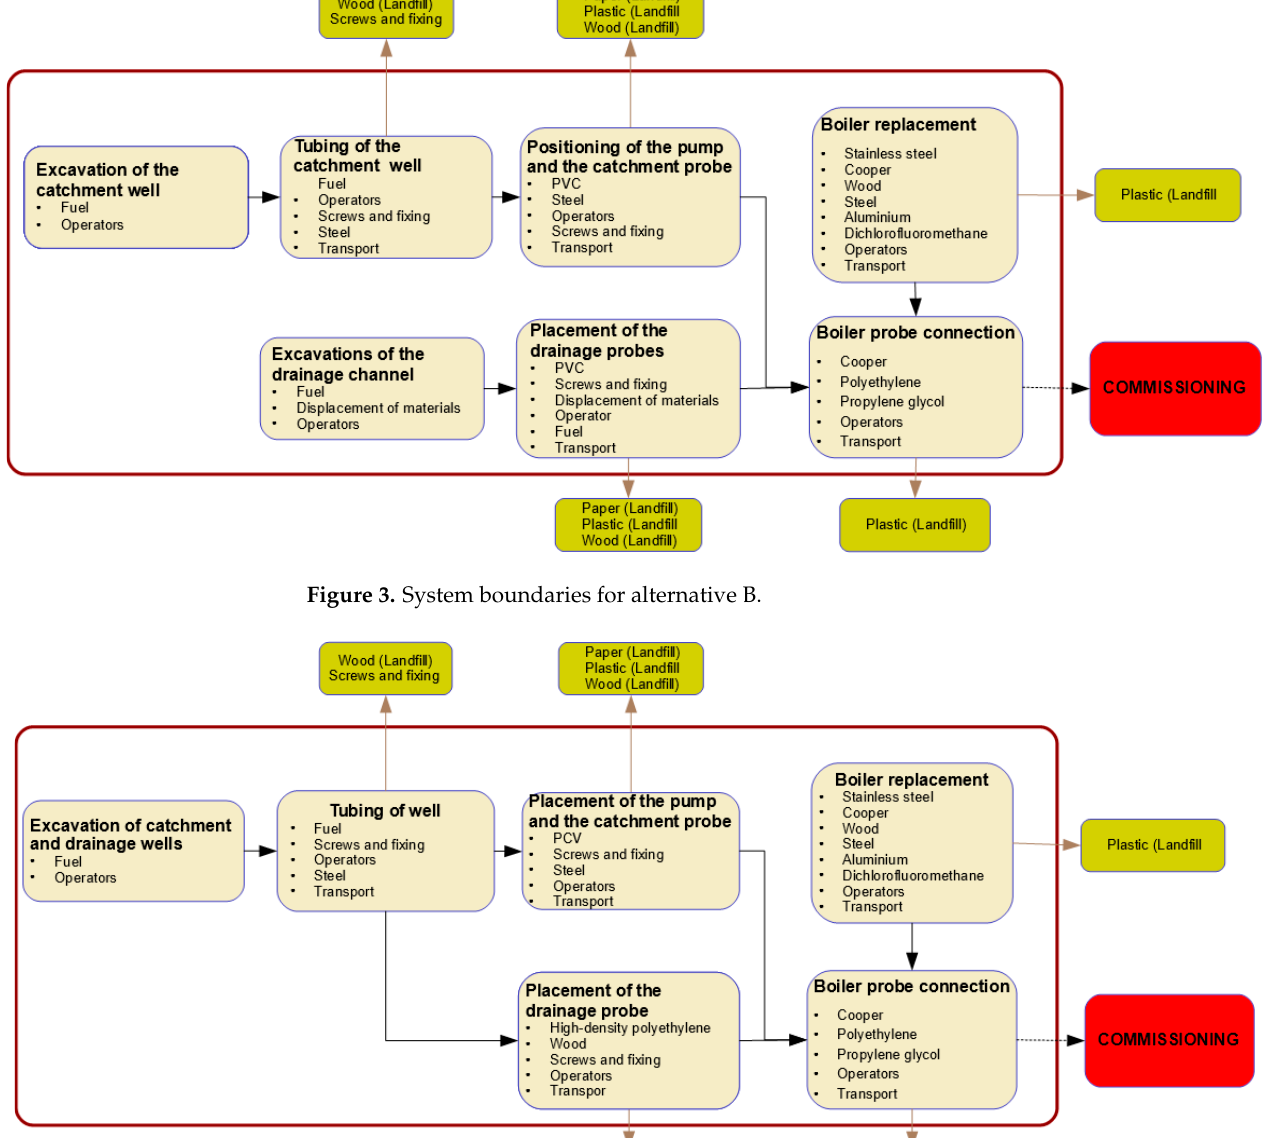
Figure 2. System boundaries for alternative A.